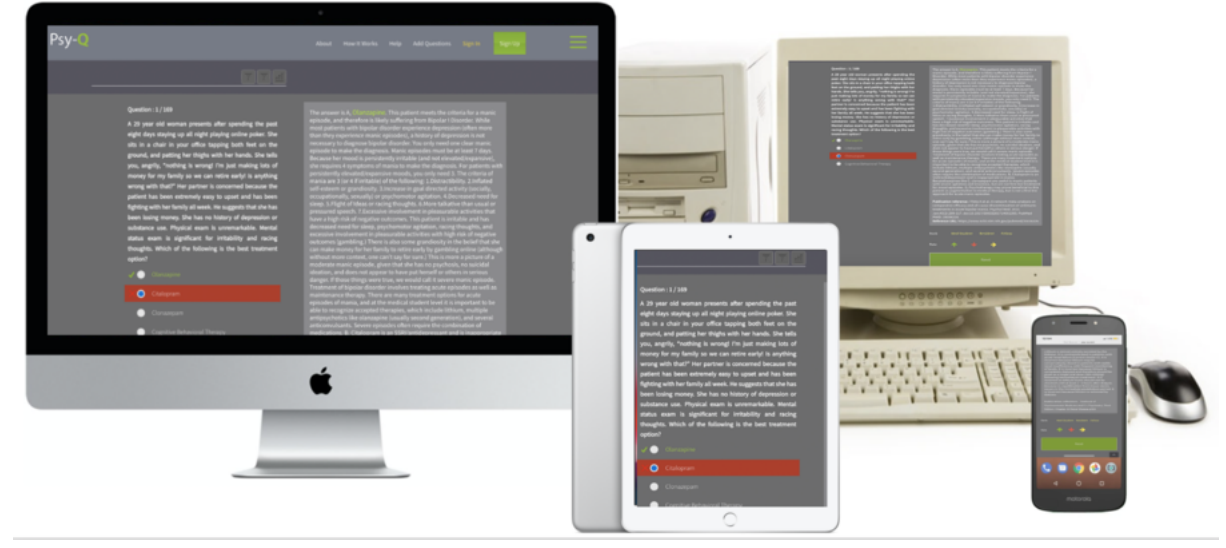
Figure 1. Screenshots of Psy-Q on multiple platforms. Multiple platforms can be used to access